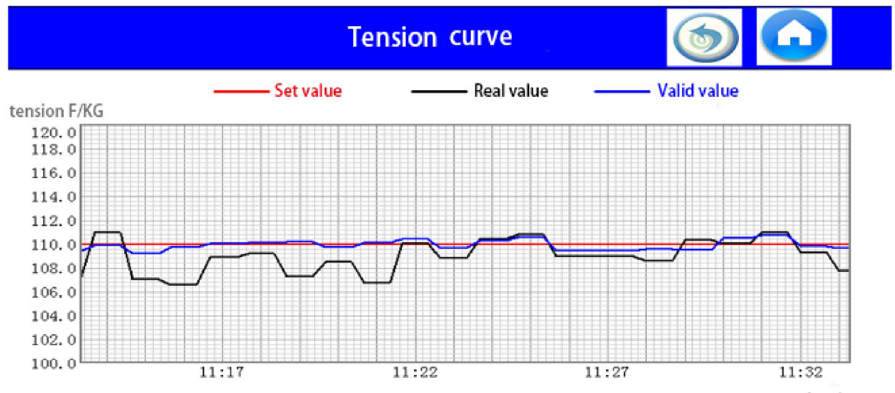
Fig. 20 Tension curve interface